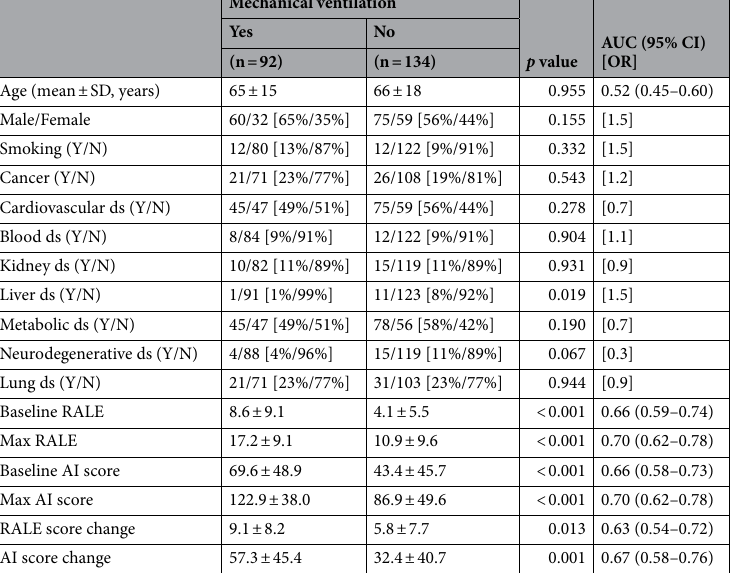
Table 2. Summary of assessed variables for predicting need for mechanical ventilation in COVID-19 patients from Site A. Maximum RALE and AI scores were the strongest predictors. SD standard deviation, Y/N present or absent, ds disease, max maximum, AUC area under the curve, CI confidence interval, OR odd’s ratio, % percentage. Numbers in square parenthesis represent odd’s ratios (R2-14).